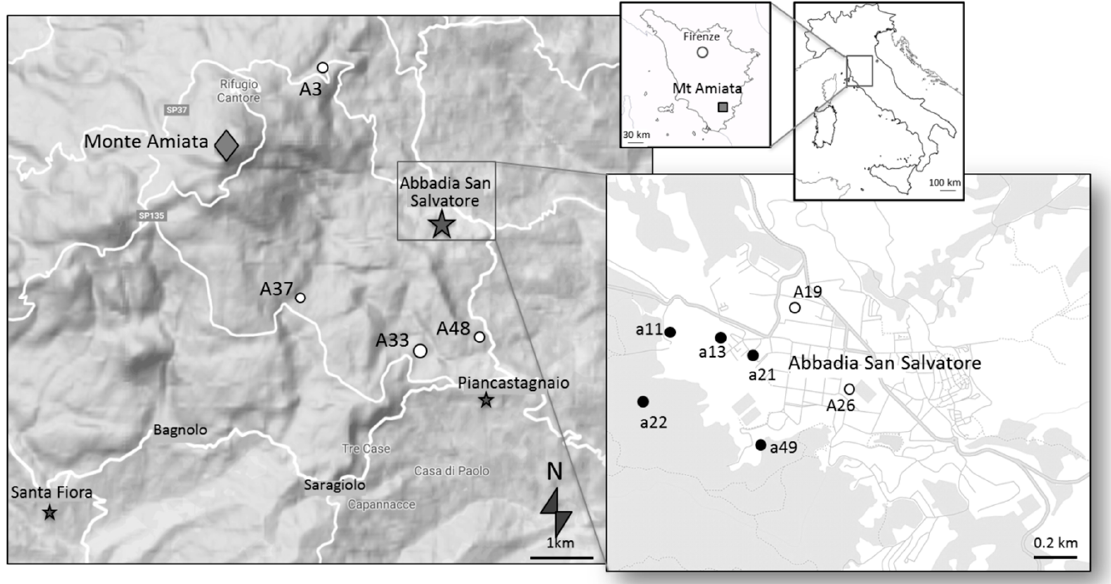
Figure 1. ( a ) Location of sampling sites in the Monte Amiata area; ( b ) zoom of sampling sites in the Abbadia San Salvatore town.